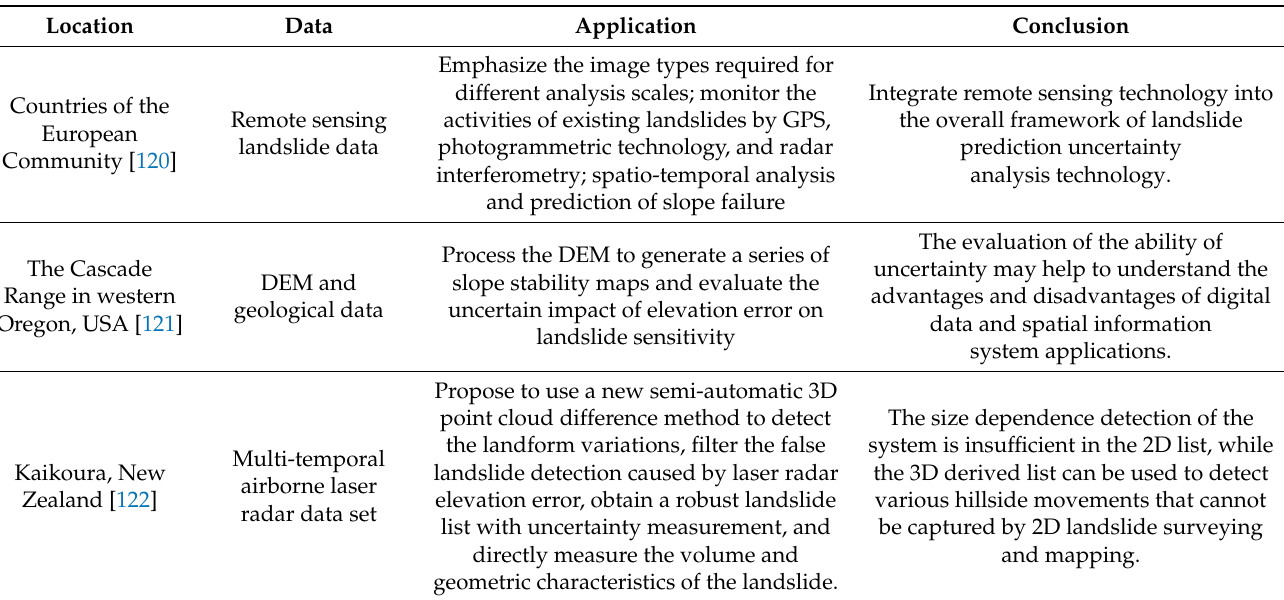
Table 6. Landslide disaster prediction data and application